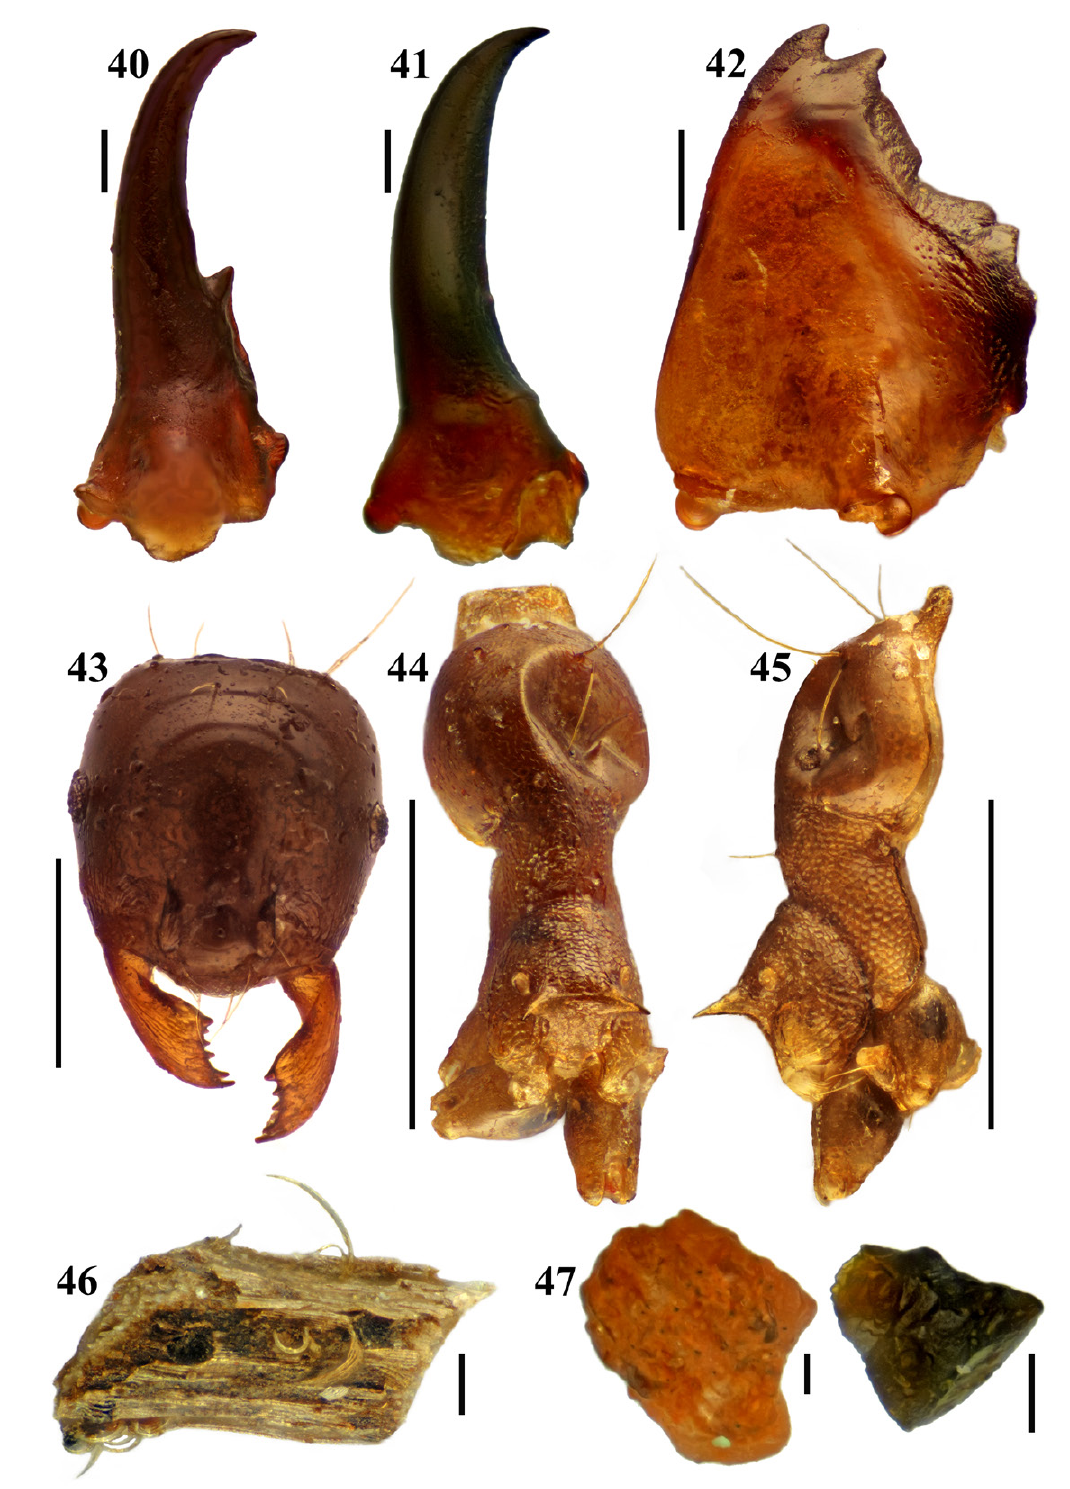
Figs 40–47. Gut contents of Oryctopterus varuna sp. nov. 40–41 . Mandibles of Odontotermes sp. soldier. 42 . Mandible of Odontotermes sp. worker. 43 . Head of Pheidole sp. 44–45 . Thorax of Pheidole sp. dorsal and lateral views. 46 . Piece of stem. 47 . Pebbles. Scale bars: 40–42, 46–47 = 0.1 mm; 43–45 = 0.5